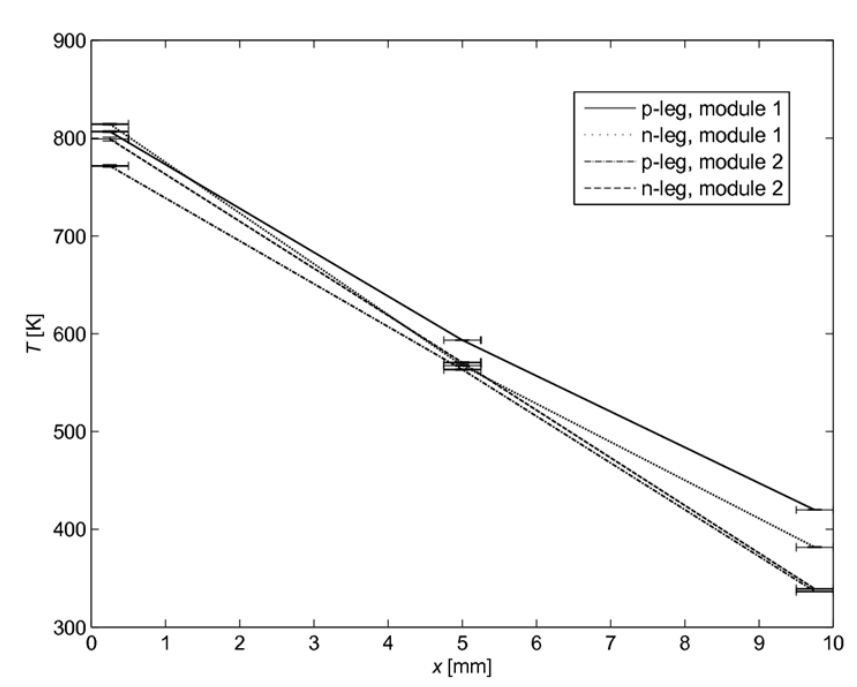
Figure 5. Temperature distribution along the p- and n-type legs for two modules with l = 10 mm. Error bars indicate spatial accuracy (±0.25 mm) of thermocouple